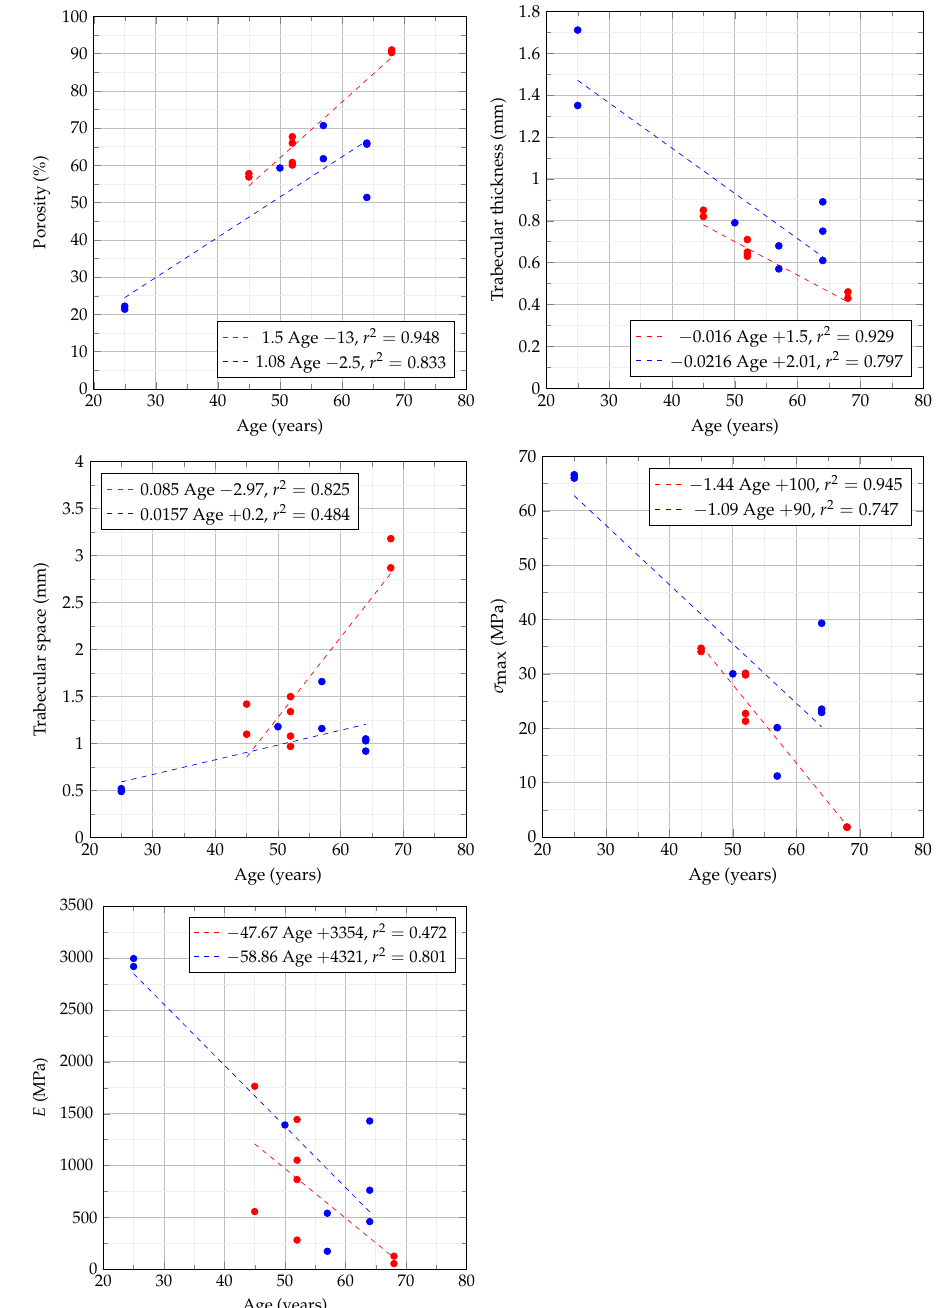
Figure 10. Comparison of quality parameters against age and gender. All graphs show raw data from female donors in red dots and those from male donors in blue. Dashed lines correspond to the linear regression of the corresponding data. Significant differences among genders were found in the case of trabecular space ( t -test, p = 0.0017).